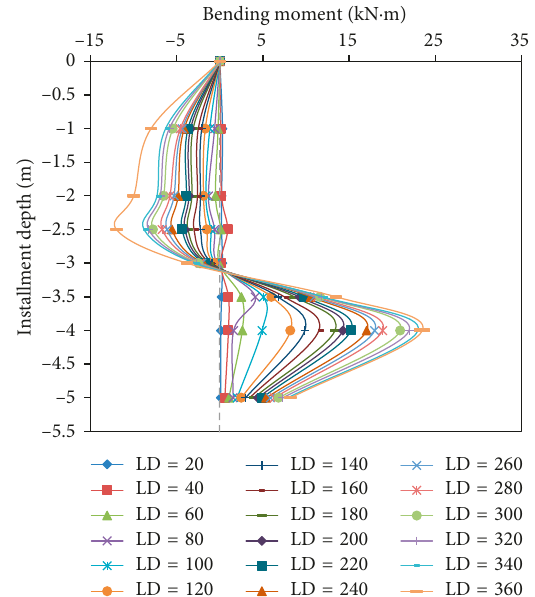
Figure 14: Variation of bending moment with installment depth for Test C (loading displacement short for LD).